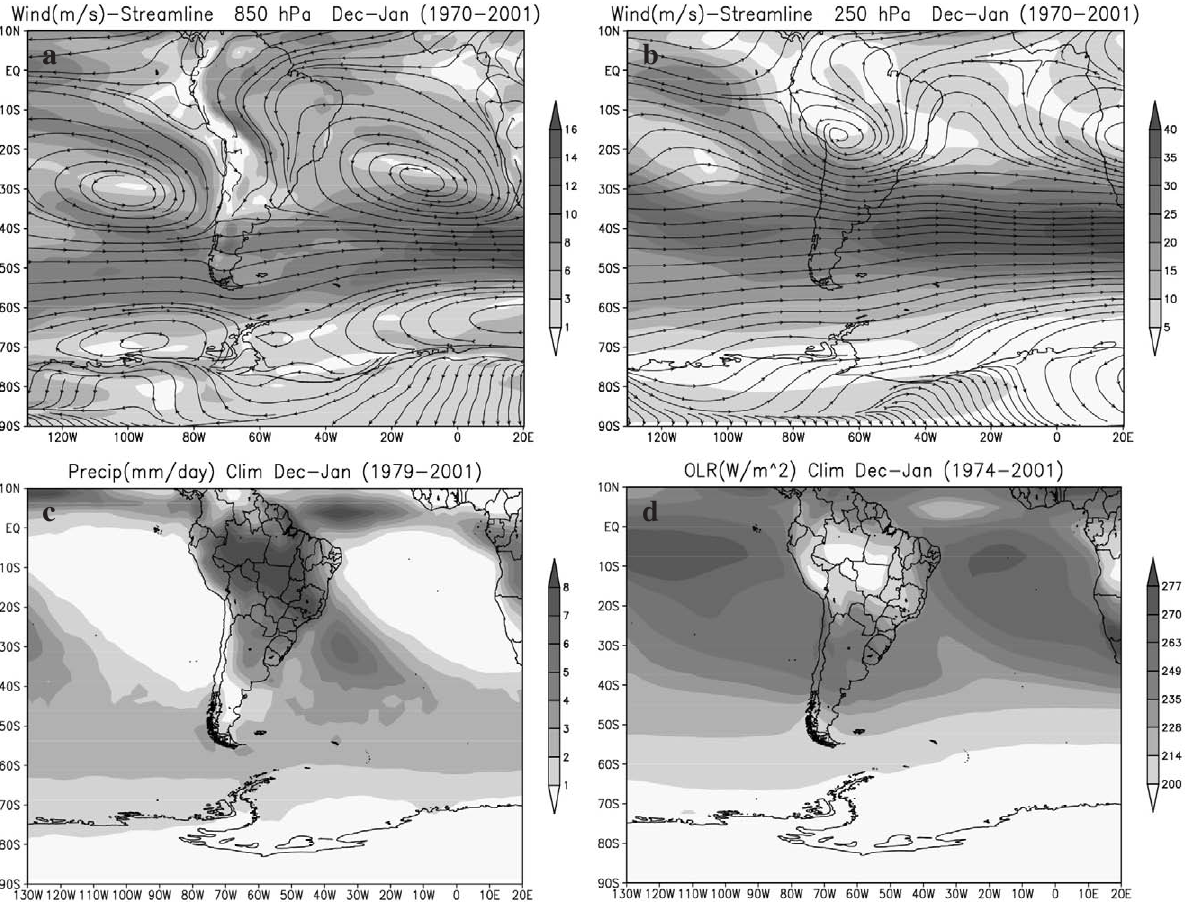
Fig . 4. – Climatology fields of: a) wind velocity (m s -1 ) and streamlines for 850 hPa; b) wind velocity (m s -1 ) and streamlines for 250 hPa; c) precipitation (mm/day); d) outgoing long wave radiation (W m -2